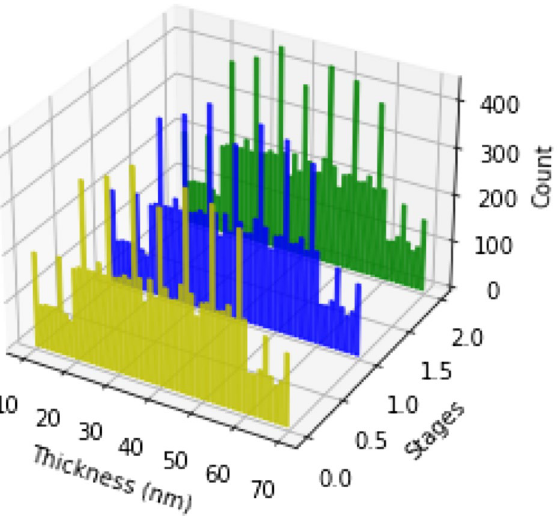
Figure 4. A histogram of counts of reflective indices at different gold thicknesses and DNA deposition stages. 0, 1, and 2 represent bare, immobilization, and hybridization stages.